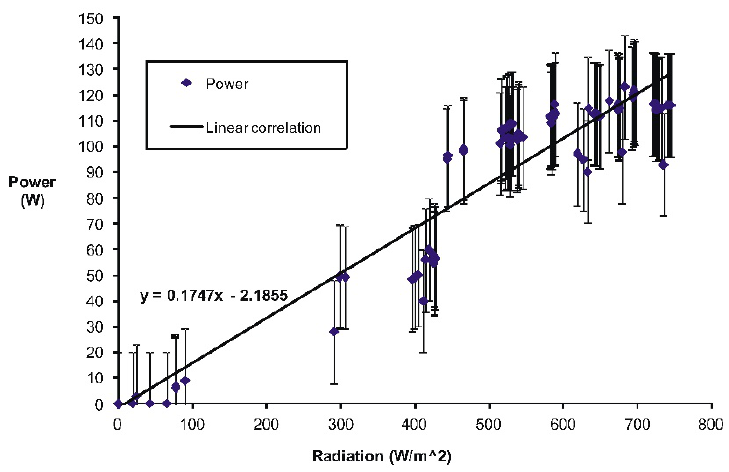
Figure 15. Correlation between power and incident radiation.